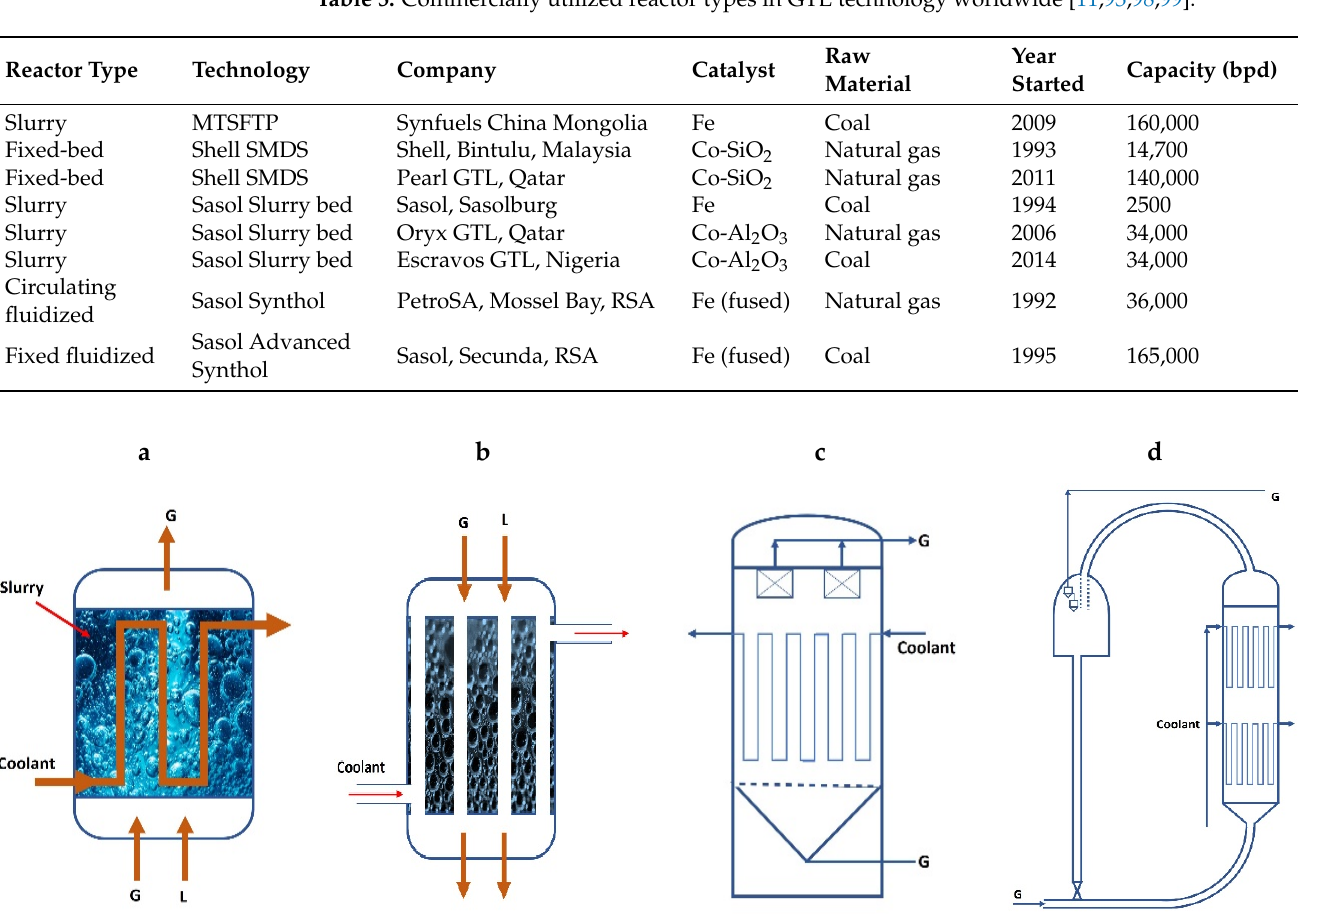
Table 5. Commercially utilized reactor types in GTL technology worldwide [11,93,98,99].